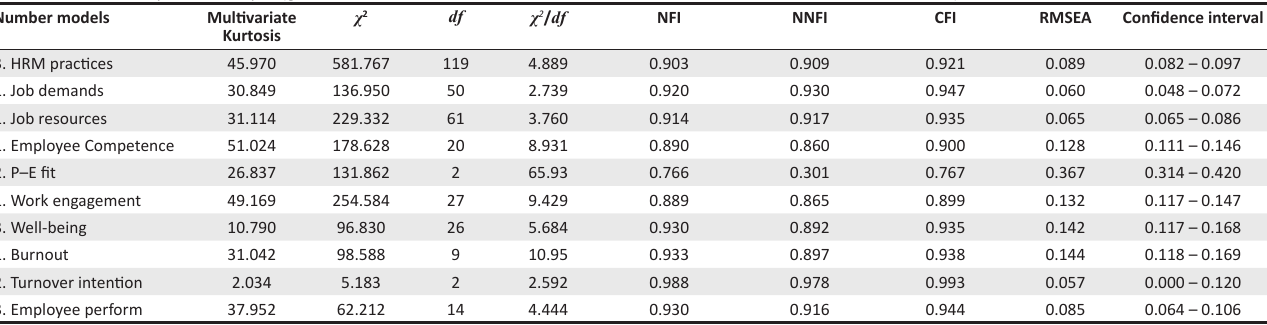
TABLE 3: Confirmatory factor analysis (goodness-of-fit statistics for the measurement models of the different variables, n = 487). Number